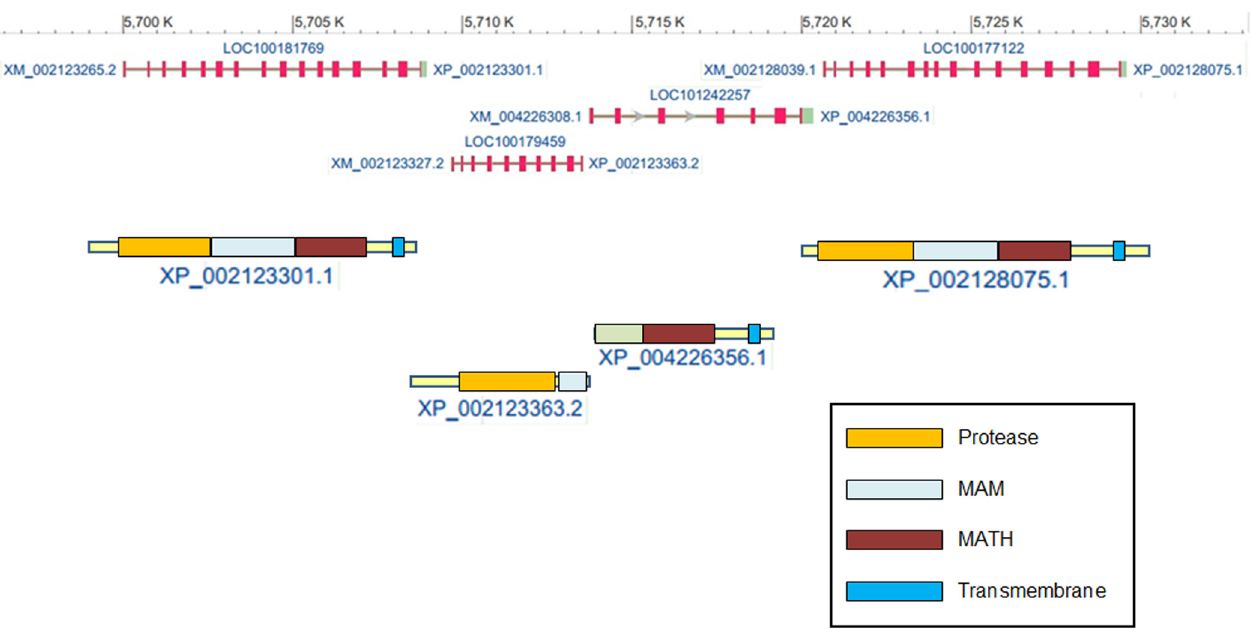
Fig 7. Structures of the Ciona meprins and locations and structures of their genes in chromosome 8 of C . intestinalis , according to NCBI data. As explained in the text, there are only three meprin genes, the two “ genes ” in the middle being just one, which is erroneously divided into two in the NCBI databases. Red boxes in the genes are coding exons, separated by lines corresponding to